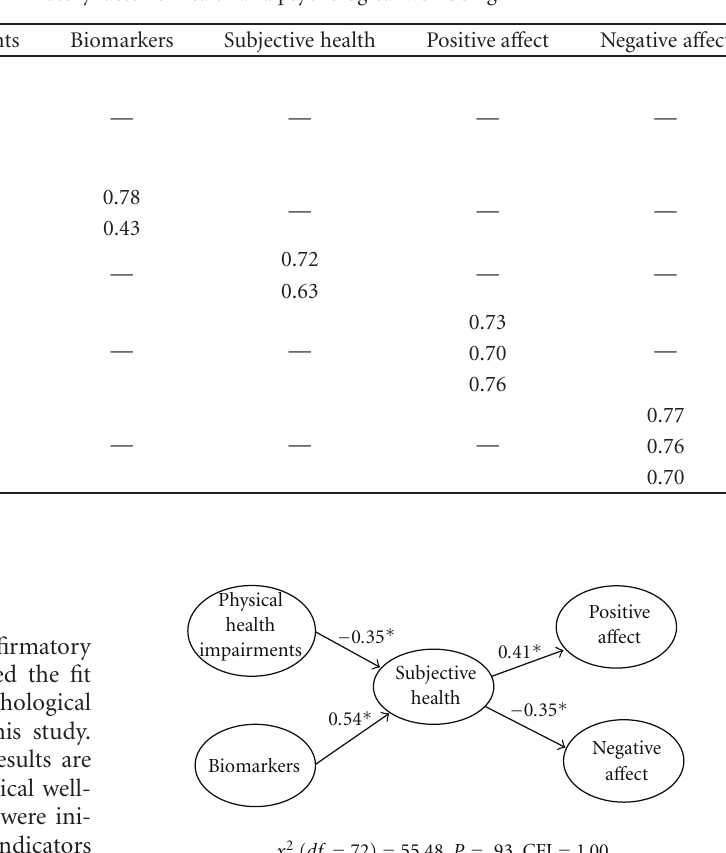
Table 2: Factor loadings in confirmatory factor of health and psychological well-being.